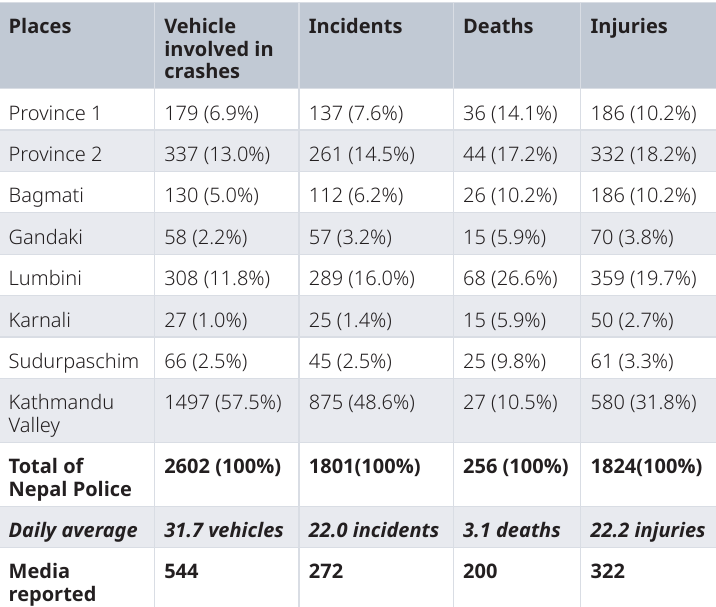
Table 1. Distribution of the road crash incidents, vehicles involved in crashes, deaths and injuries during national level COVID-19, 82 days lockdown from police record and media reporting in